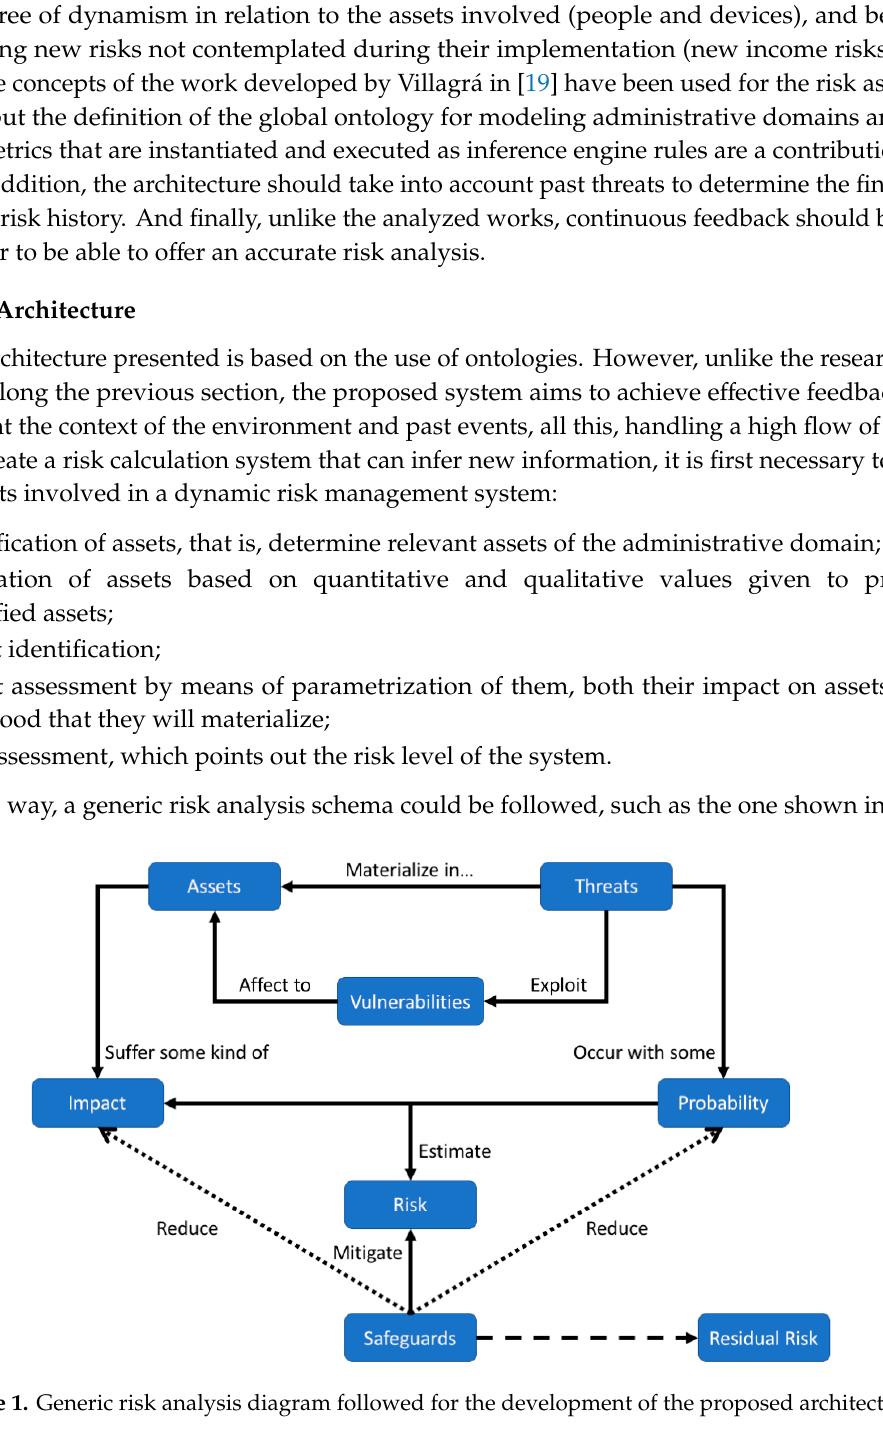
Figure 1. Generic risk analysis diagram followed for the development of the proposed architecture.